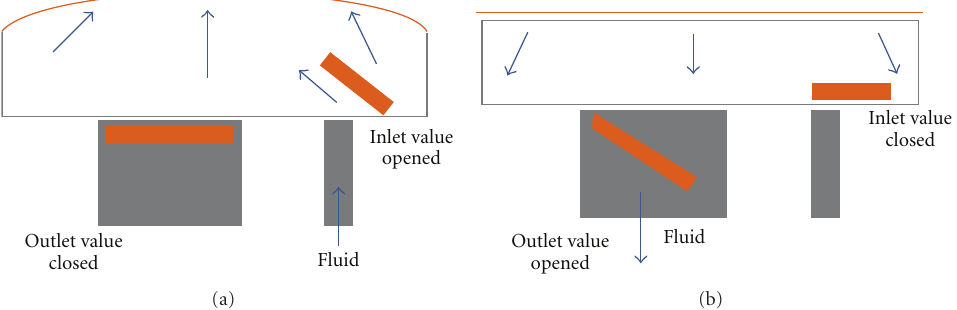
Figure 3: Actuating mechanisms in an ethanol injection system. (a) Sucked working fluid into the chamber. (b) Exhausted working fluid from the chamber.